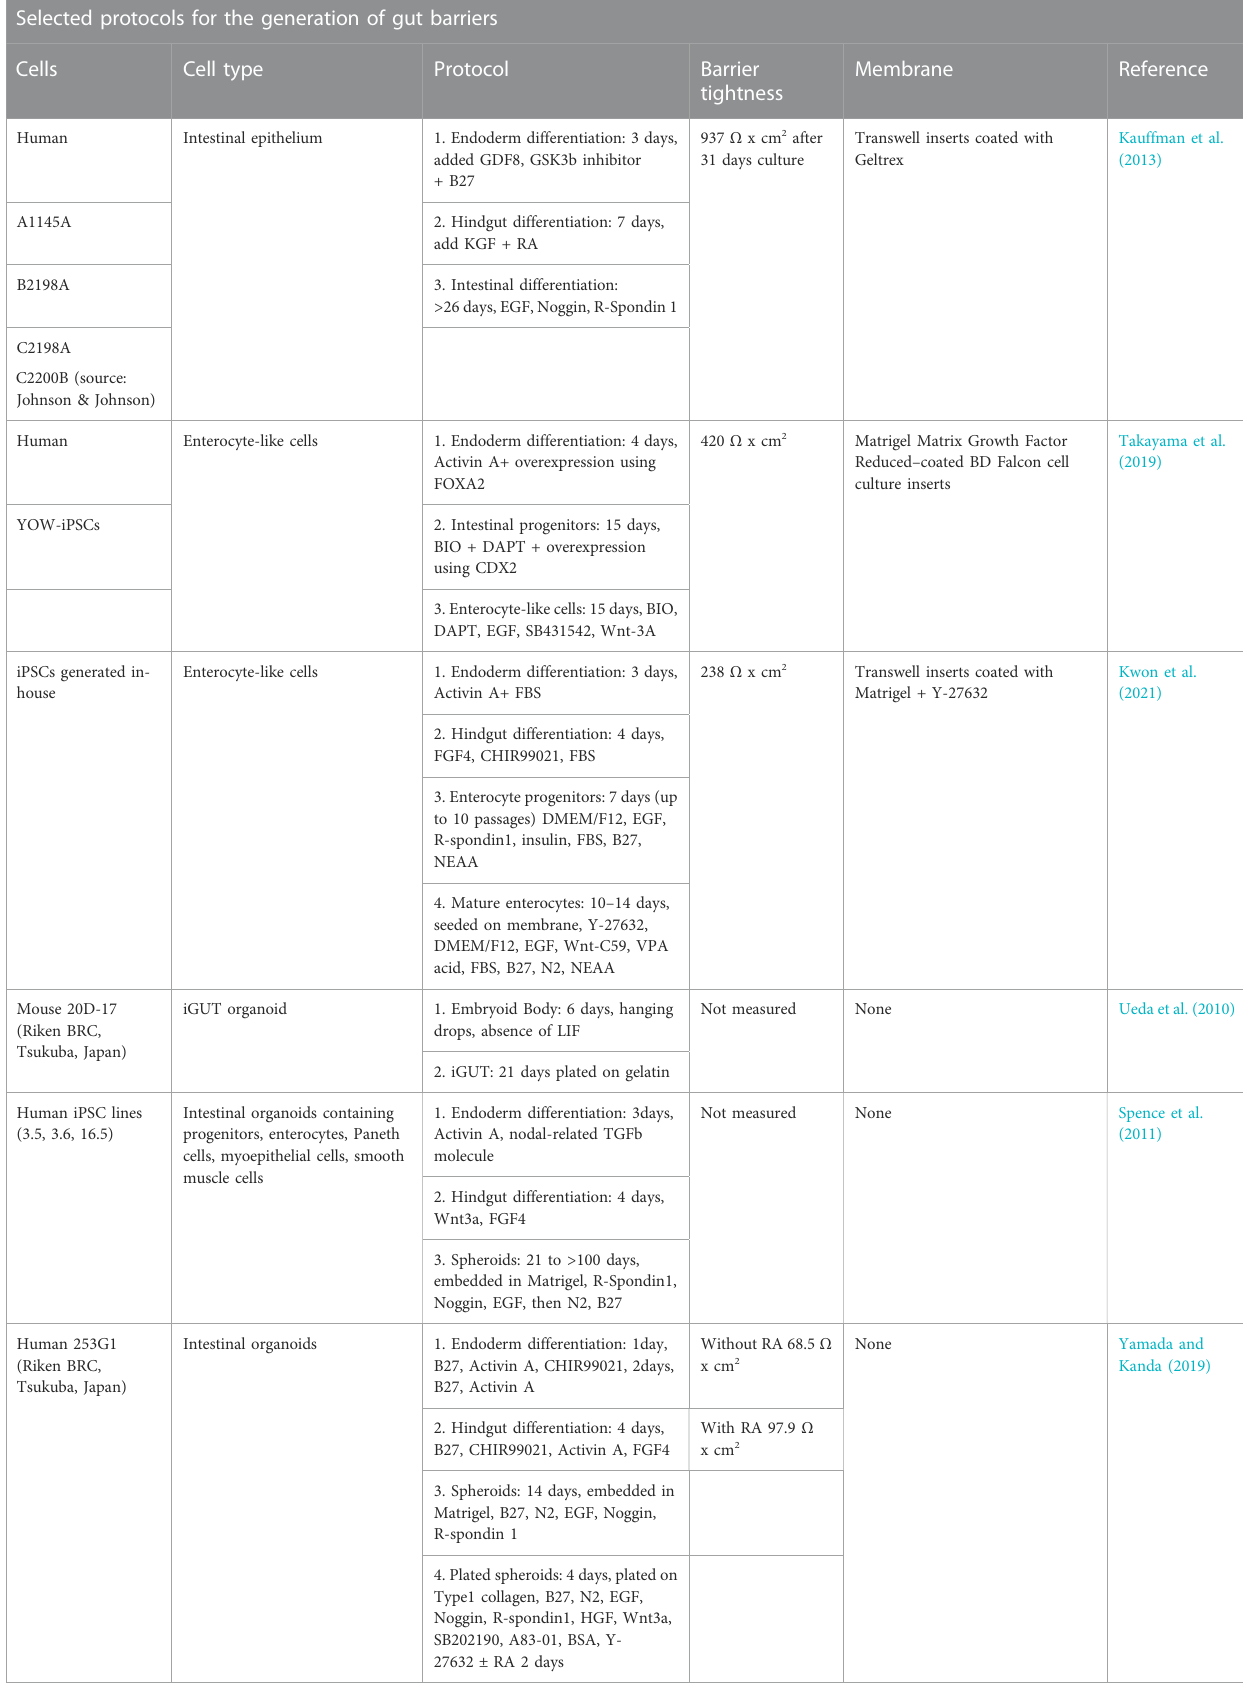
TABLE 1 Overview of a selection of protocols for the generation of gut barriers using induced pluripotent stem cells with or without the presence of other cells. Selected protocols for the generation of gut